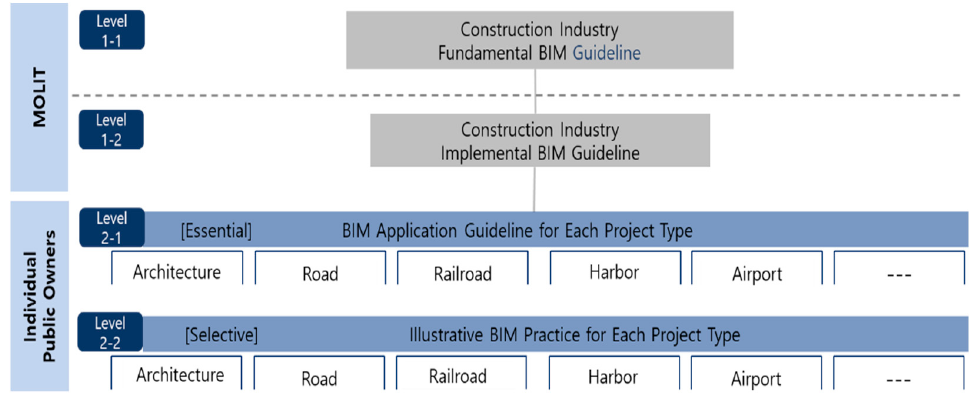
Figure 1. The hierarchical structure of public BIM guidelines in